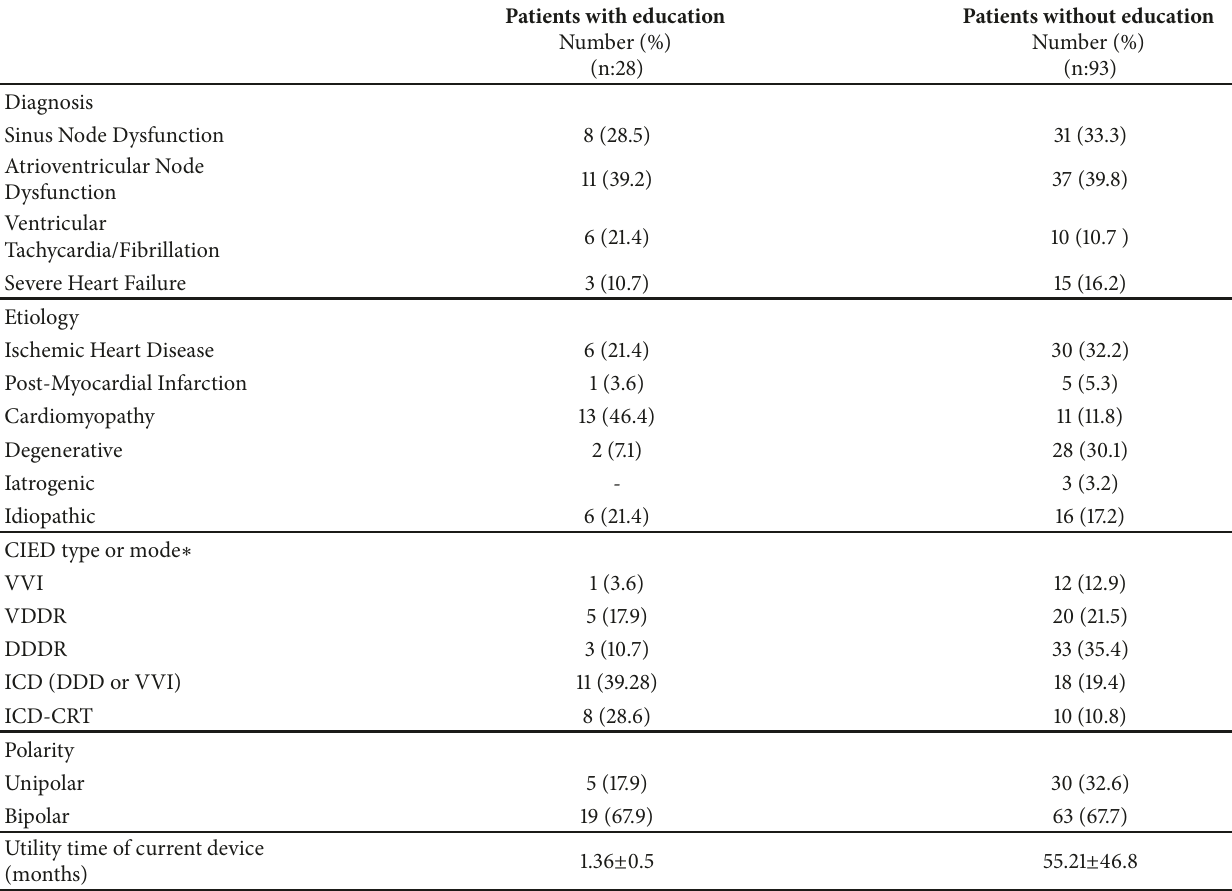
Table 2: Diagnosis , underlying etiology, type/mode and lifetime of the cardiac implantable electronic device (CIED), and generator replacement number of the patients.